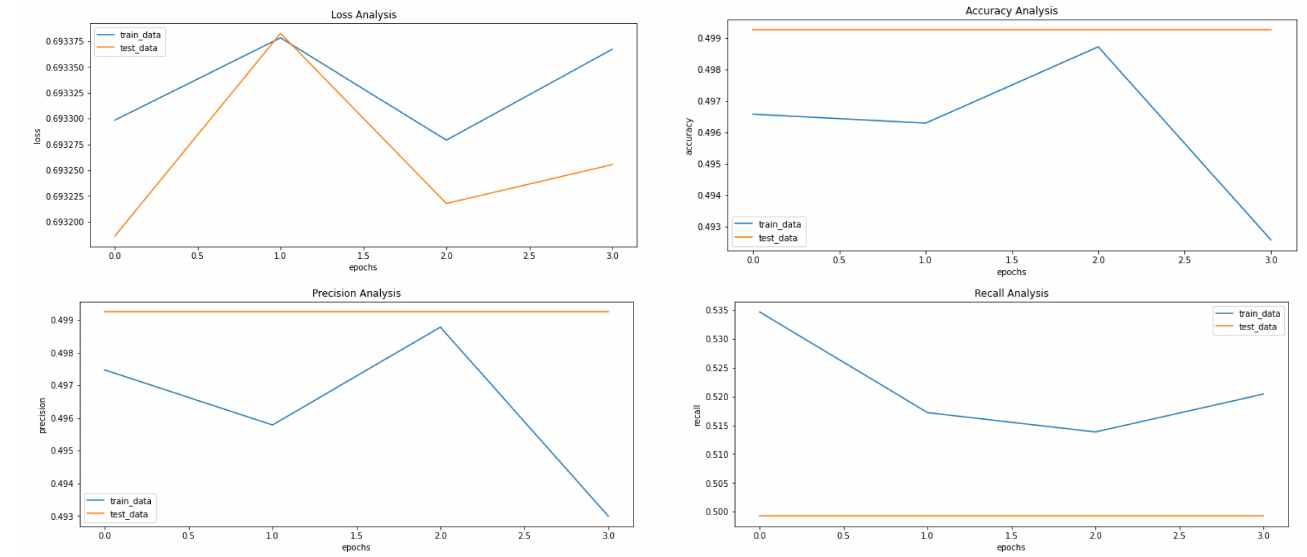
Figure 9. Results achieved after classification using CNN after applying and reconstructing input images using Denoising VAE. It shows loss, accuracy, precision and recall from left to right.